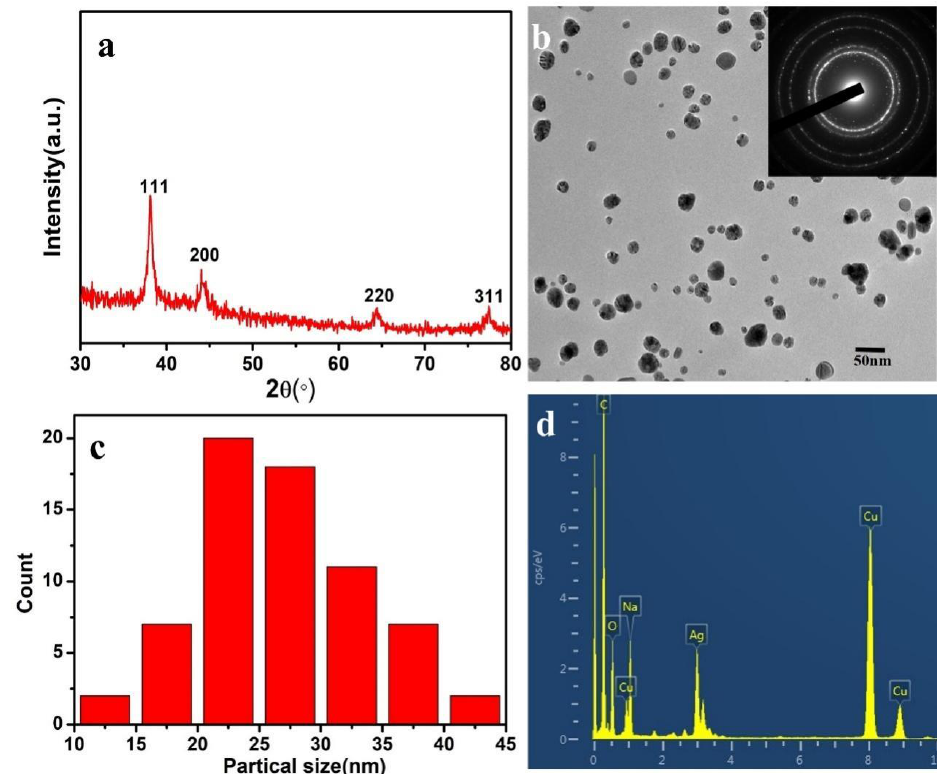
Figure 2. ( a ) XRD pattern of Ag NPs, ( b ) TEM images (inset: SAED pattern), ( c ) Size distribution and ( d ) EDS spectrum of CMS/PVP-Ag NPs.